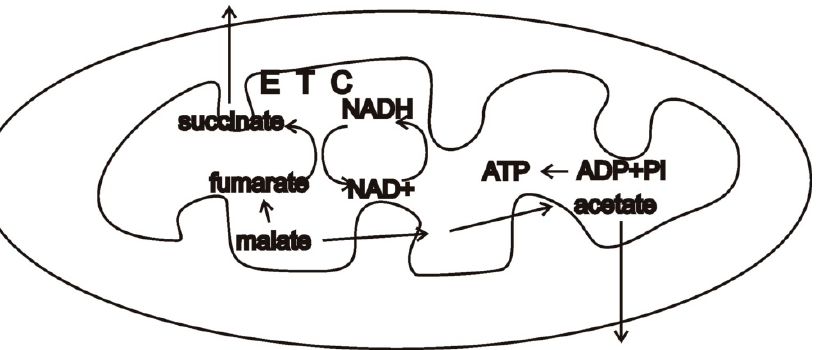
Figure 3. Simplified schemata of malate dismutation [16], a possible type of anaerobic metabolism of a protomitochondrion. Malate is oxidized to pyruvate and acetate, reducing NAD + to NADH. Malate is also reduced to fumarate and succinate, and possibly other products, oxidizing NADH to NAD + by using a portion of the electron transport chain (ETC). A syntrophic partner that could take up succinate, acetate, and other products would be valuable by diminishing end-product inhibition (Figure 4).